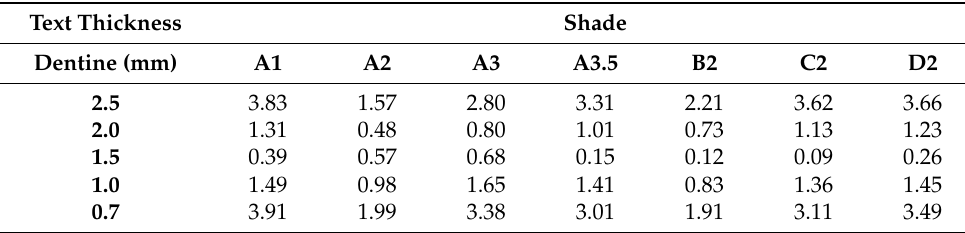
Table 2. ∆ E 00 color differences between measured and predicted CIE-L*a*b* values for all monolithic samples tested in our study.